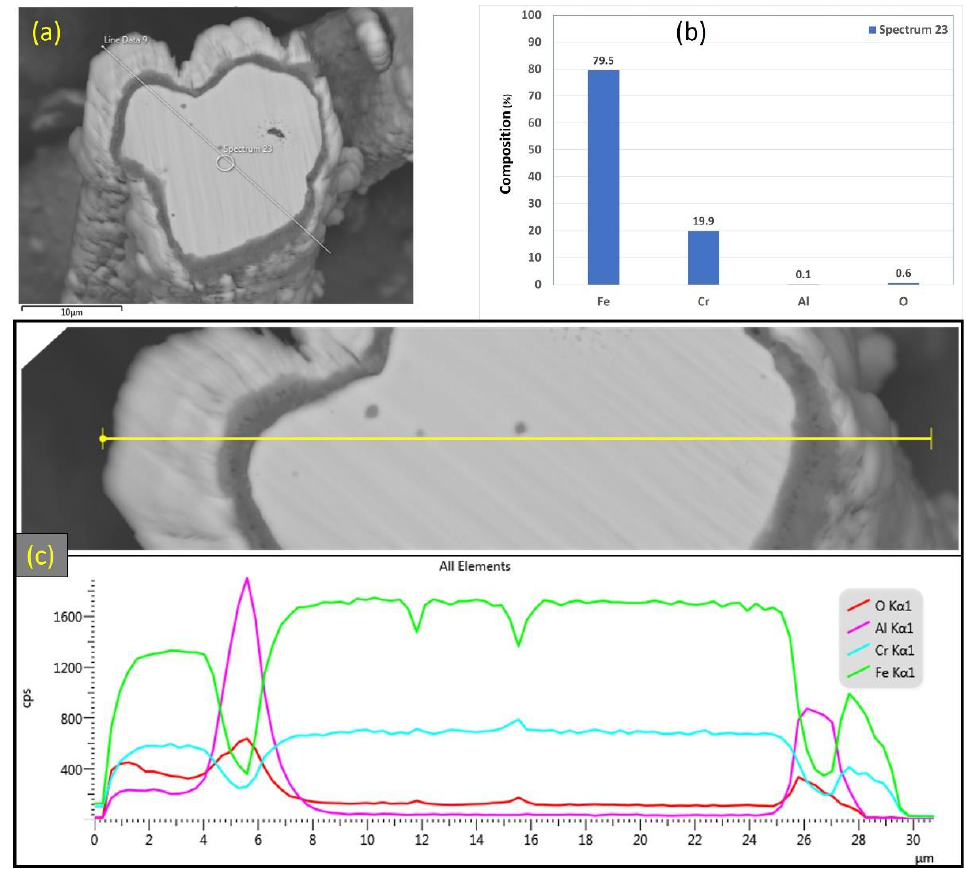
Figure 16. ( a ) SEM micrograph of a cross- section of the 17 μm FeCrAl fiber after 18 MSHT cycles, ( b ) EDS scan at the center of the fiber, ( c ) the characteristic X-ray counts along the specified line scan (Line Data 9) marked in ( a ).